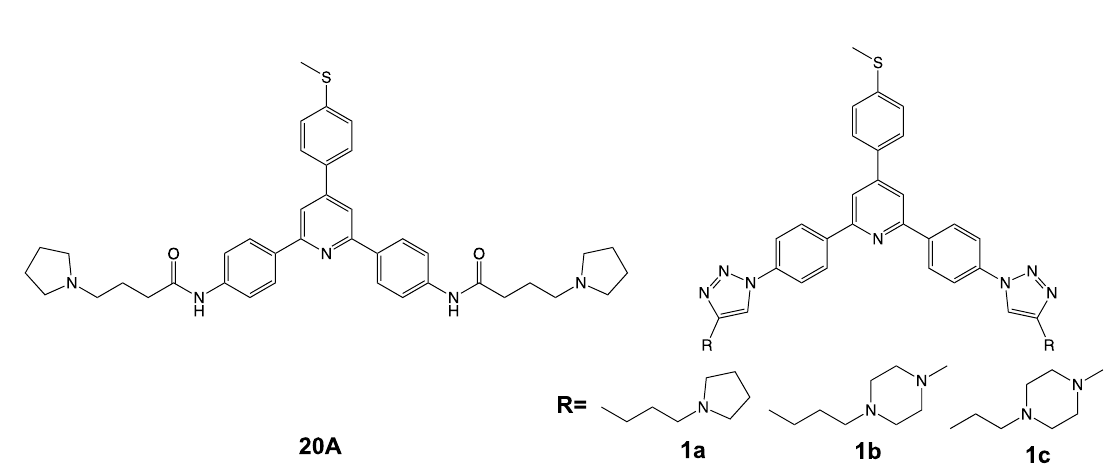
Figure 1. Formula of triarylpyridine compounds used in this study.